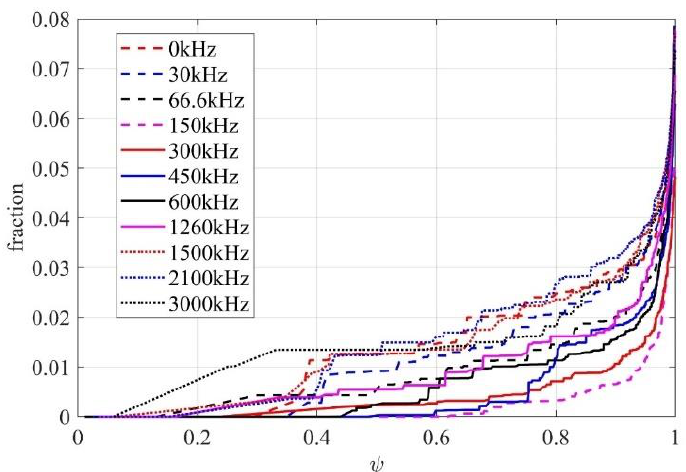
Figure 12. Cumulative probability density distribution of sphericity, normalized by the volume of injected liquid.